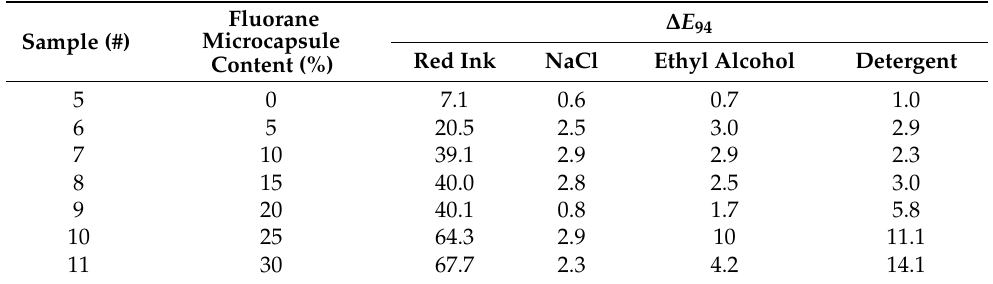
Table 7. The color difference of the topcoat with fluorane microcapsules after liquid resistance.